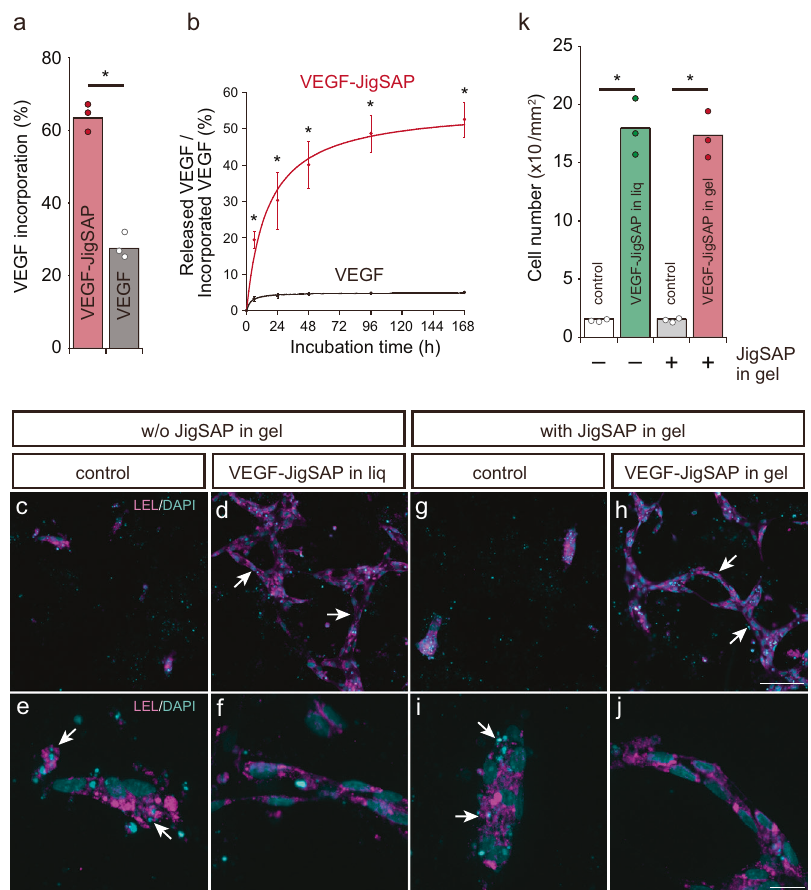
Fig. 3 Sustained release and in vitro angiogenesis of JigSAP-tagged VEGF protein. a The ratios of VEGF incorporation into peptide nano fi bers. VEGF- JigSAP (red) and non-tagged VEGF (black) were incorporated into JigSAP peptide nano fi bers. n = 3. b The ratios of released VEGF to incorporated VEGF. n = 3. c – j Endothelial cell marker Lycopersicon esculentum lectin (LEL) (magenta) and DAPI (cyan) images of HUVECs. Arrows in d and h show lumen-like formation by HUVECs. Arrows in e and i show condensed nuclei, a feature typical of dead cells. Scale bar: 50 μ m ( c, d, g, h ) and 20 μ m ( e, f, i, j ). k Cell scoring of HUVECs by stereology. n = 3. * P < 0.05 (Student ’ s t -test against VEGF ( a , b ) and control ( k ), two-sided). Data are mean ± SEM. Source data are provided as a Source Data fi le. Abbreviations; VEGF (vascular endothelial growth factor), JigSAP (jigsaw-shaped self-assembling peptide), HUVEC (Human umbilical vein endothelial